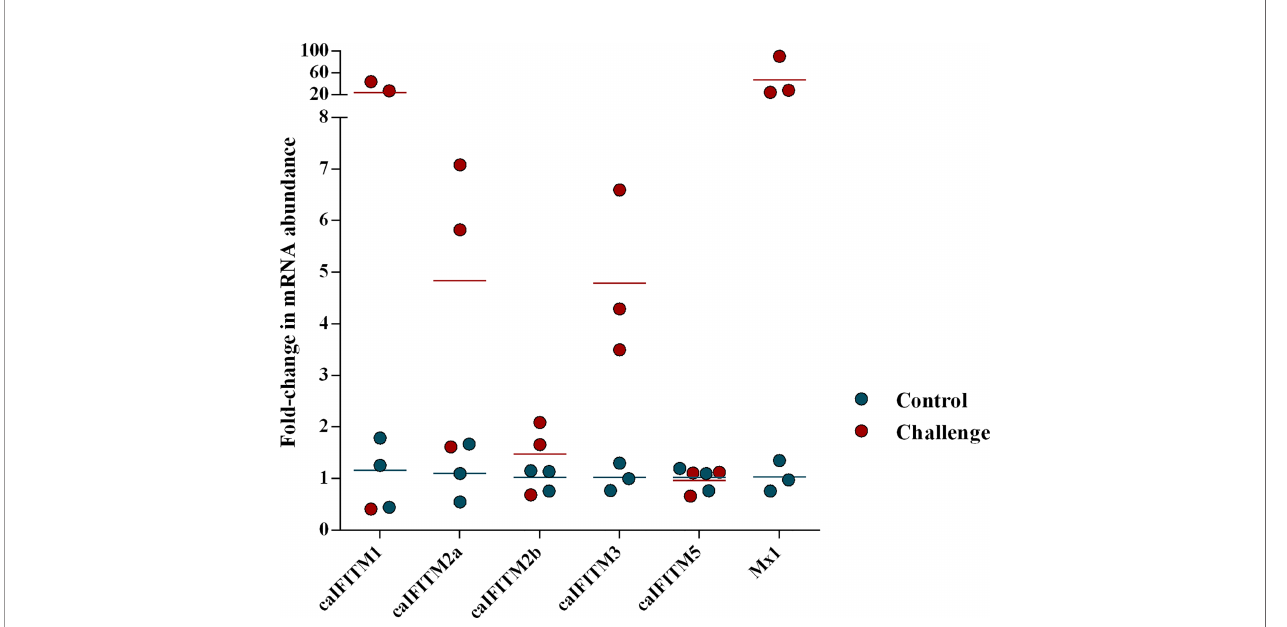
FIGURE 4 | The change of expression level of caIFITMs in beagles after being challenged with H3N2 CIV. The experimental beagles ( n = 3) were inoculated intranasally with 10 6 EID 50 of H3N2 CIV strain GD/2018. In the control group, beagles ( n = 3) were treated with PBS in the same way. At 1 dpi, all the animals were euthanized. The expression level of caIFITMs in the lung samples were determined by RT-qPCR. All data were expressed as means ±